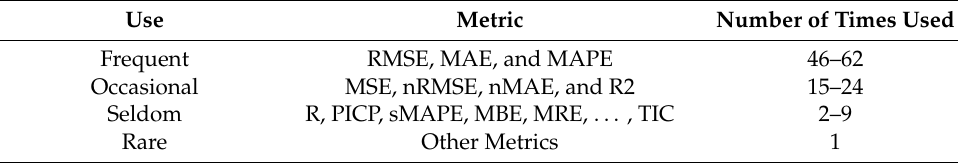
Figure 3. Common ways to measure and evaluate the error of models predicting quantitative data. Table 7. Frequency of use of model performance evaluation metrics.